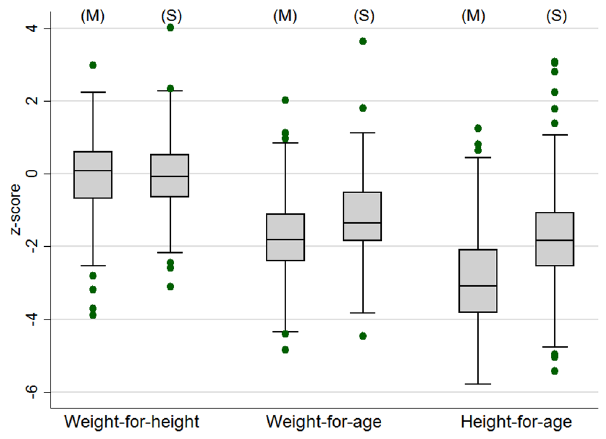
Figure 4. Boxplot showing weight-for-height, weight-for-age and height-for-age of the ex-malnourished surviving child (M) (n=386) compared to sibling controls (S) (n=277).